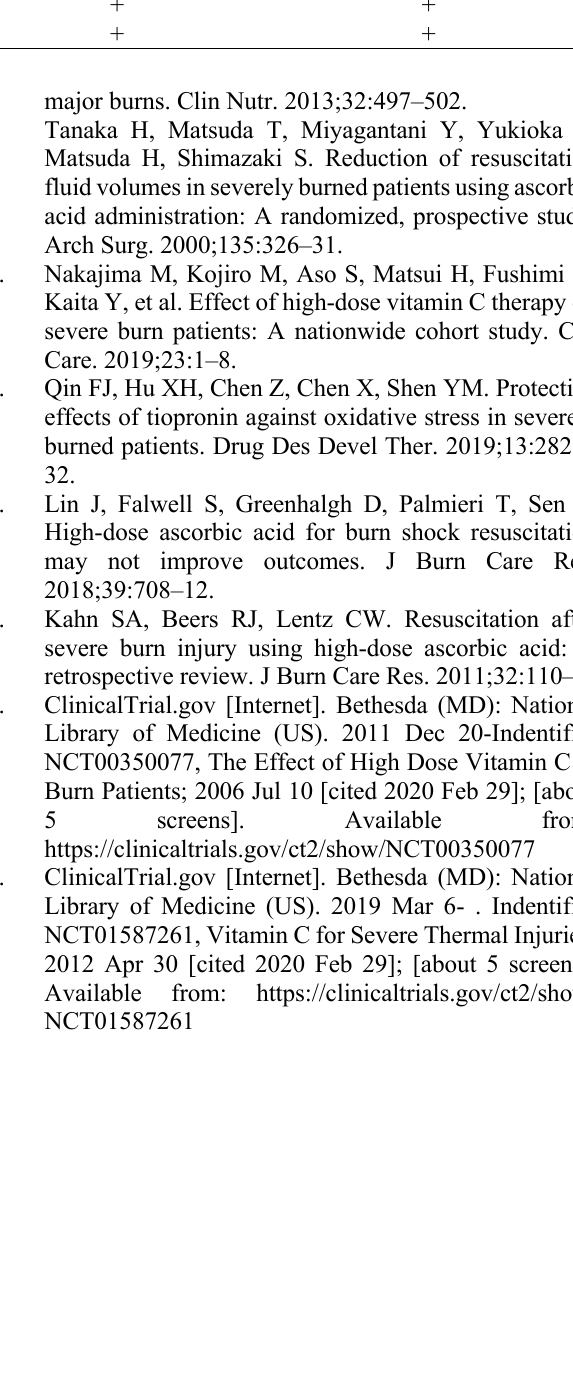
Table 4. Similarity with PICO Similarity Population Similarity Determinant Similarity Outcome Tanaka H et al.